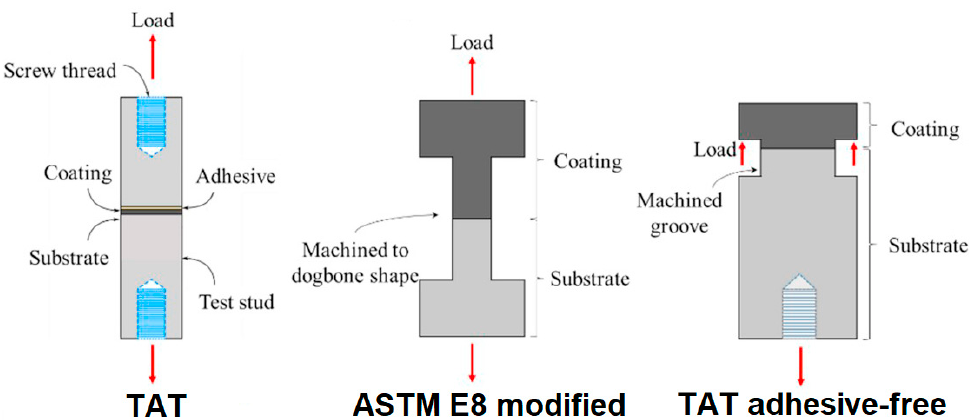
Figure 12. Schemes for CSAM adhesive testing. Reprinted with permission from Ref. [327], El-